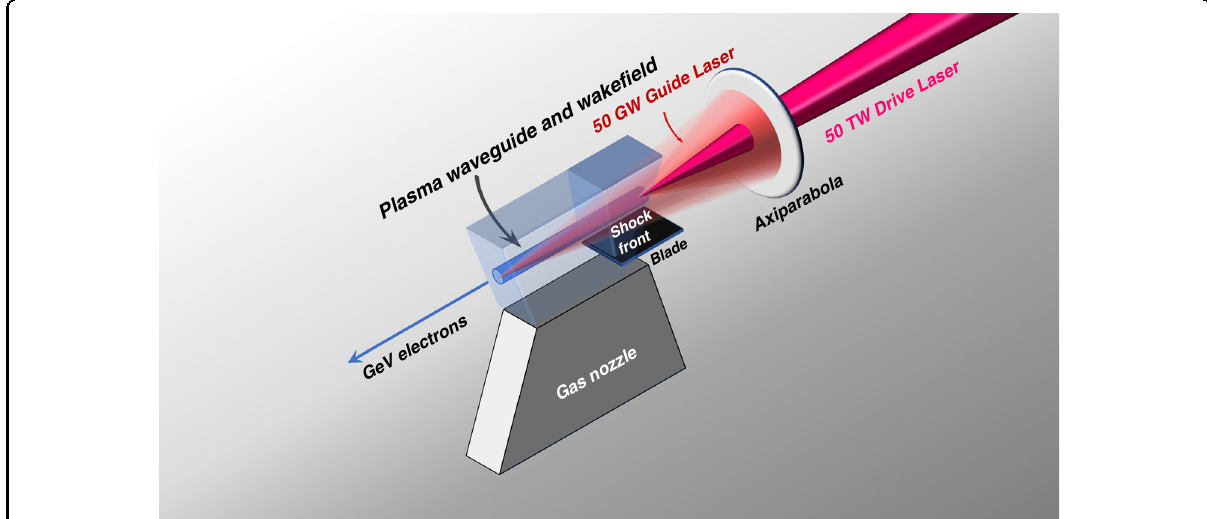
Fig. 1 Schematic view of the experimental setup for plasma waveguide and laser-driven wake fi eld